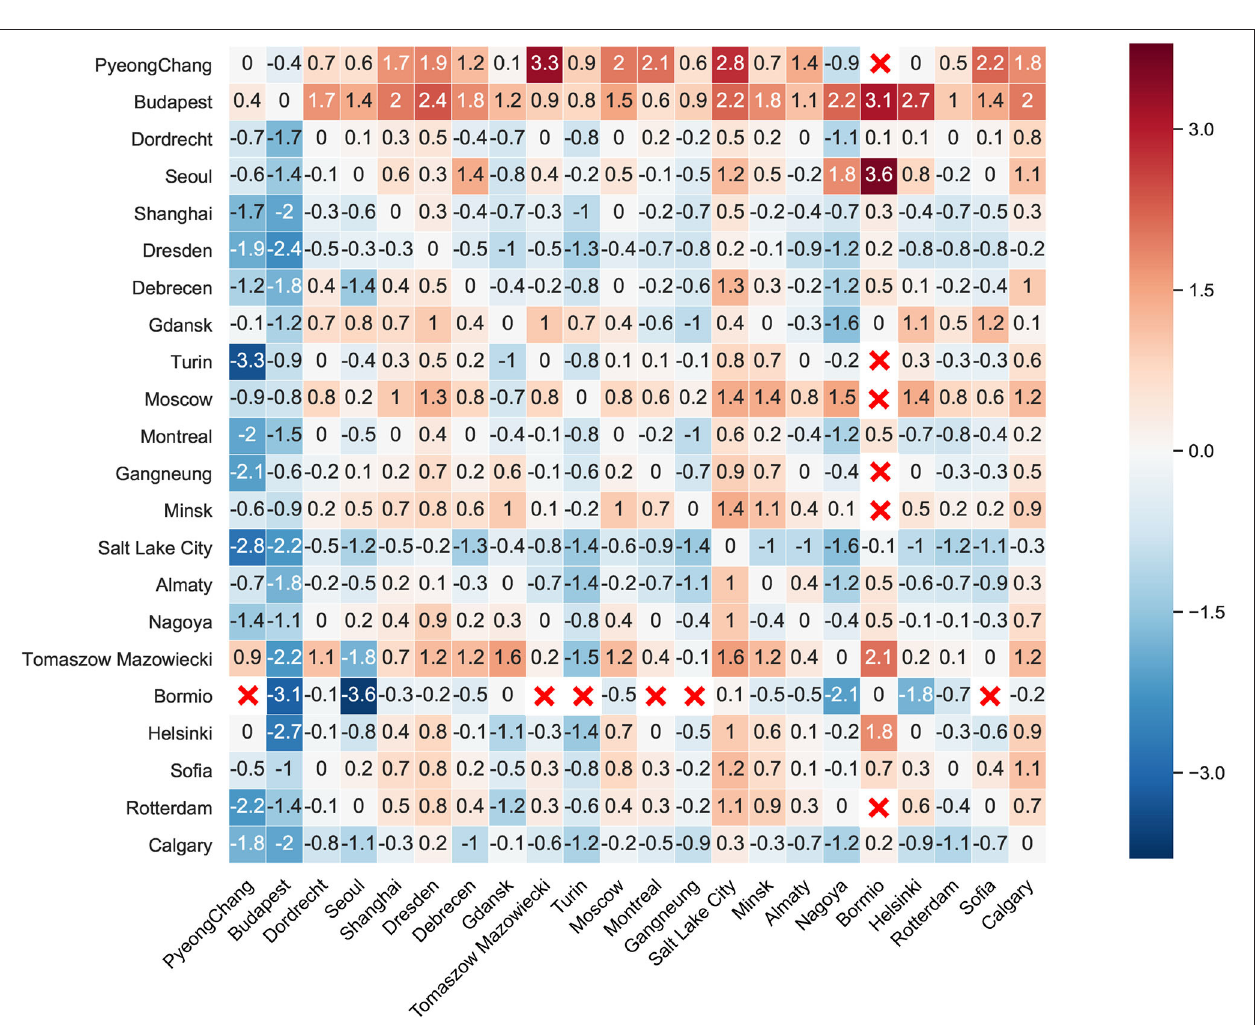
FIGURE 1 | Performance-time differences between cities. Color bar indicates the range of time differences, while red cross marks represent abnormal performance times, which are removed. The color bar on the right side of the confusion matrix suggested the scale of the fastest finishing time differences (City on vertical axis minus City on horizontal axis), blue (red) represented that City on the vertical axis was faster (slower) than City on the horizontal axis. The unit for the measurements of performance time is second.